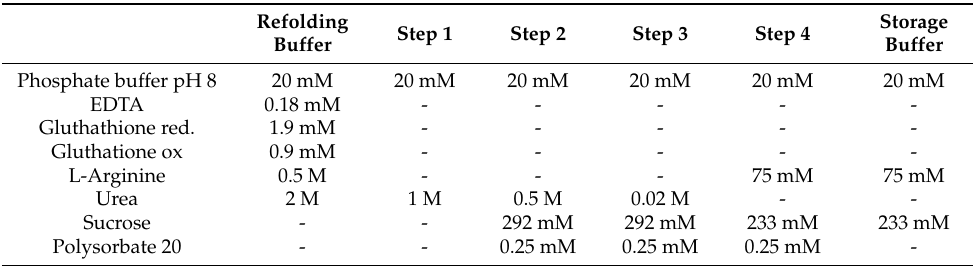
Figure A1. Electrophoretic analysis of intracellular and secreted eRBD produced in eukaryotic cells from Western blot immunodetected bands. Table A1. Battery of buffers used to gradually remove urea in the final dialysis step for protein purification from E. coli